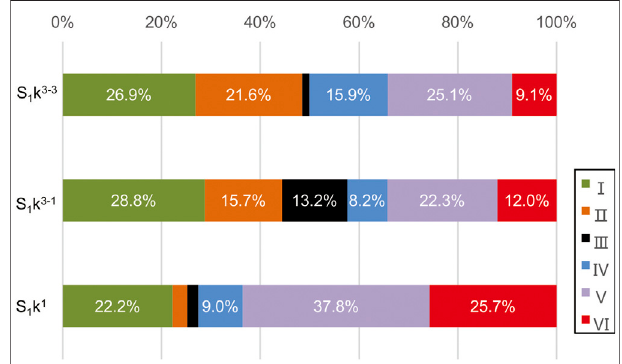
FIGURE 8 | Distribution of Diagenetic Facies Types for sandstone membersofKepingtageFormation.(Thethreerowsrespectivelyrepresentthe diagenetic facies prediction results of the three sandstone members of the Kepingtage Formation. Different colors represent the percentage ratios of different diagenetic facies. The order from left to right is the type I to type VI, as shown in the legend.)